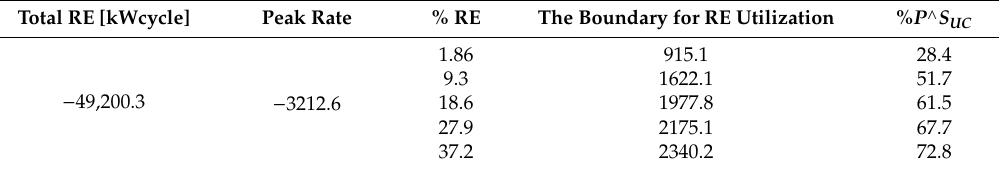
Table 4. Percentage of the peak shaving based on UC bank for the STS